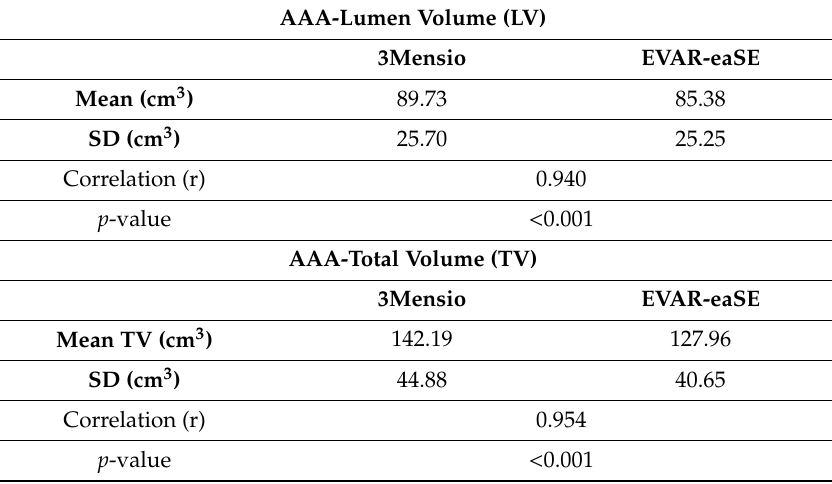
Table 5. Paired samples correlation table between EVAR-eaSE and 3Mensio volumetric computations, for 26 retrospective abdominal aortic aneurysm (AAA)